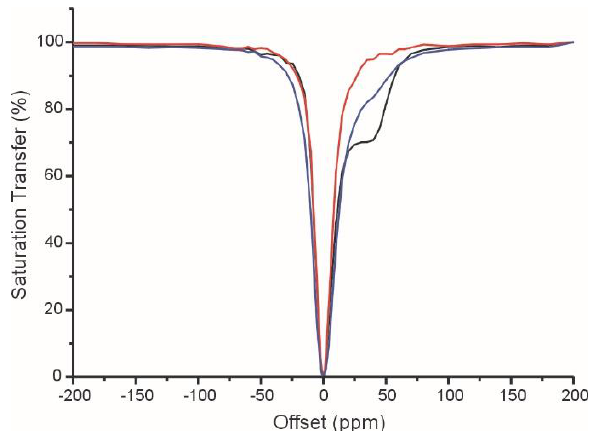
Figure 5. Z-spectra at pH 7, 300 K (irradiation time 2 s at 37 µT): [EuL1] 3+ 5.3 mM (black), [EuL2] 3+ 4.9 mM (blue) and [EuL3] 3+ 4.0 mM (red).